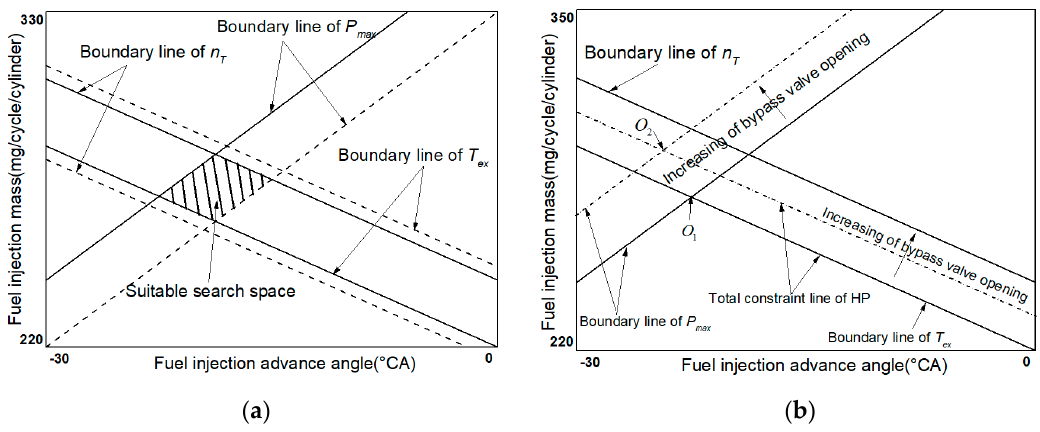
Figure 5. Decoupling process of FLA. ( a ) Constraint relationships; ( b ) Decoupling process.